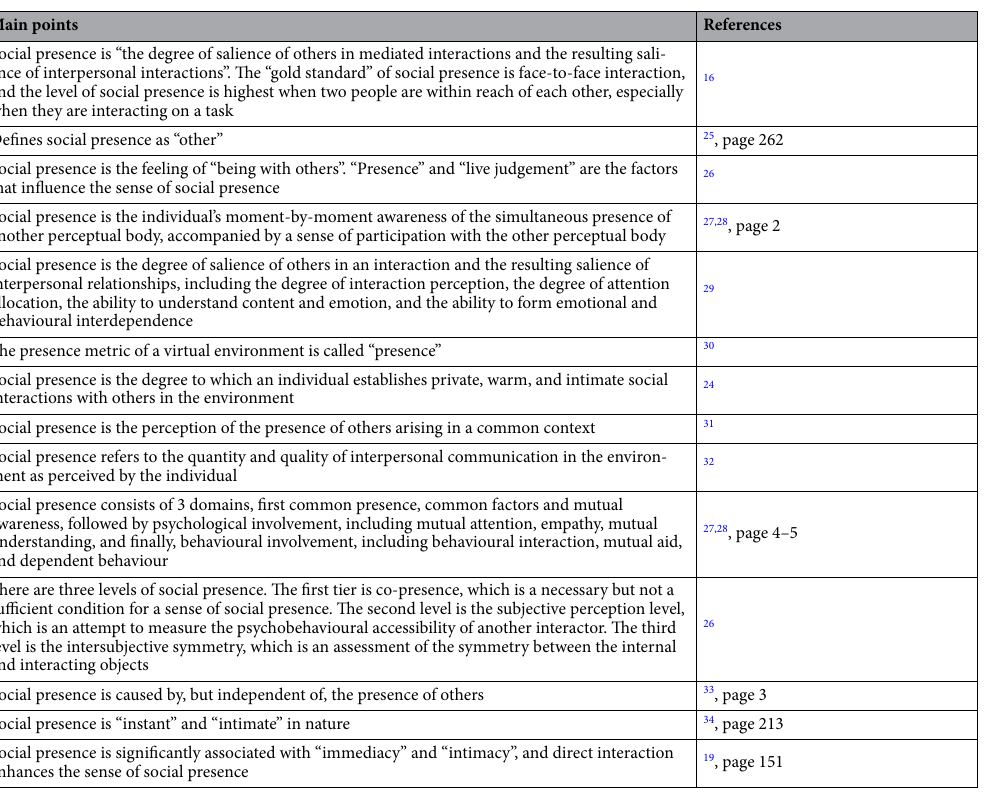
Table 1. A study of previous perspectives on social